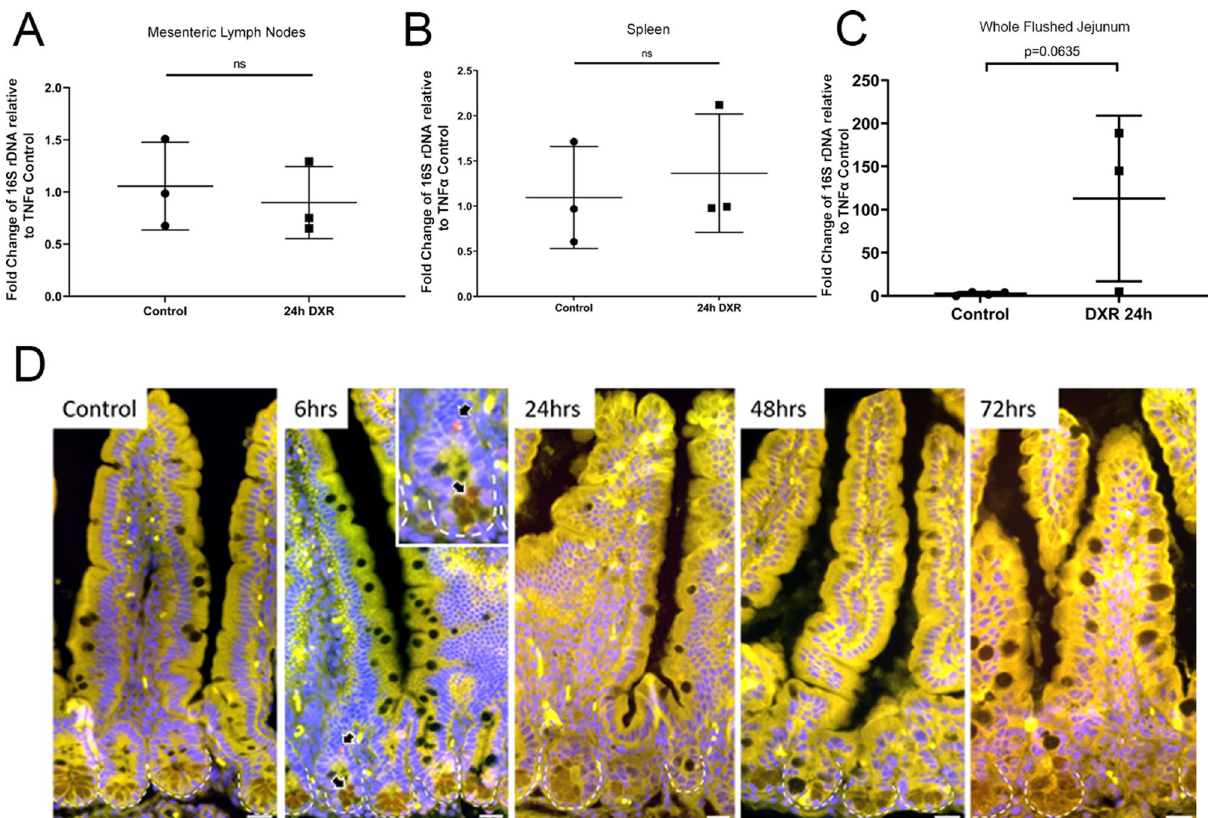
Figure 5. DXR in vivo does not result in bacterial translocation into the local lymph tissues or submucosa. ( A – C ) Mesenteric lymph nodes ( A ), spleen ( B ), and whole flushed jejunum ( C ) were isolated from control mice or mice treated with DXR. 16S rDNA quantification was performed relative to host TNFα transcript expression. ( D ) Representative 16S rRNA fluorescence in situ hybridization (FISH) images of flushed jejunal tissue at various time points after doxorubicin injection (6, 24, 48, and 72 h) as compared to control jejunum. Red arrows indicate 16S FISH-positive (red) bacteria in a jejunal crypt from a mouse treated with DXR 6 h prior to sacrifice (inset). Images are representative of n = 3 per time point. Scale bar 20 μm. Statistics: ( A ) (n = 3/group), Student’s t -test, ns no